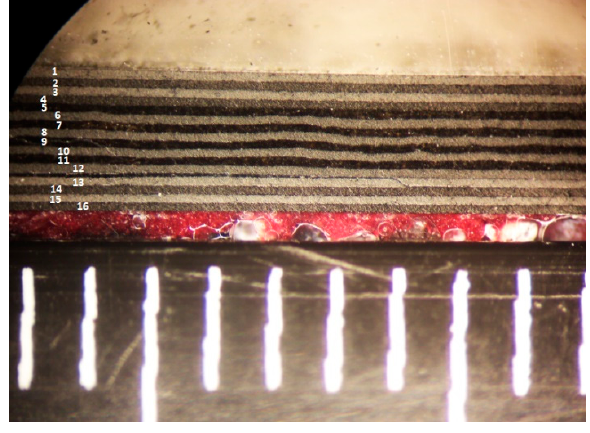
Figure 12. Cut up image shows separation between the 12th and the 13th layer.